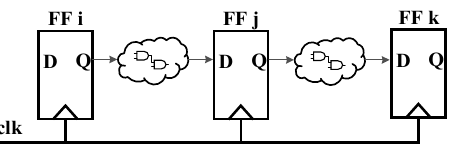
Figure 2. Timing check for circuit paths between flip ‐ flops.